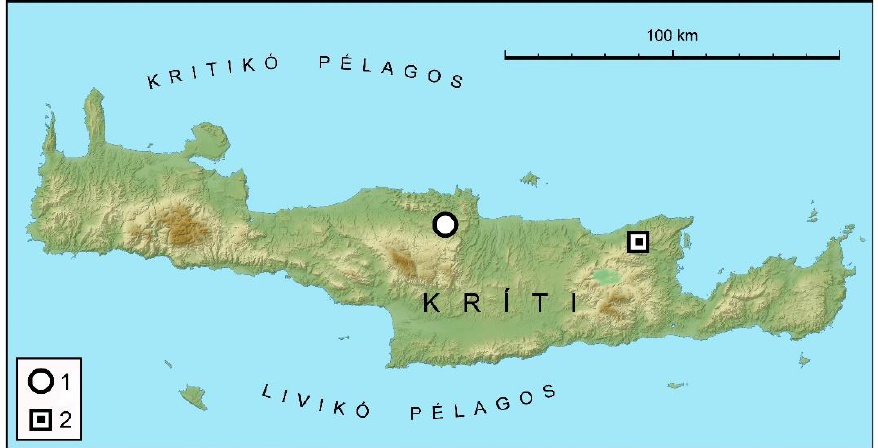
Figure 3. Distribution map of Anillini from Crete. 1: Iason minoicus ; 2: I. assingi n. sp .